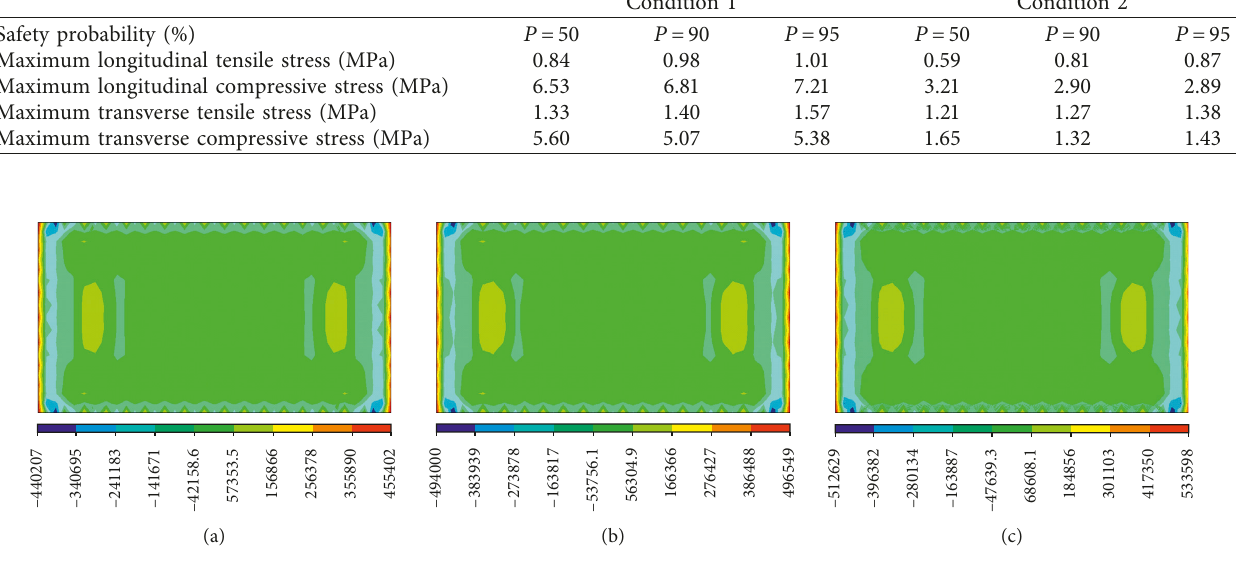
Figure 22: Normal stress of interface under condition 1. (a) P